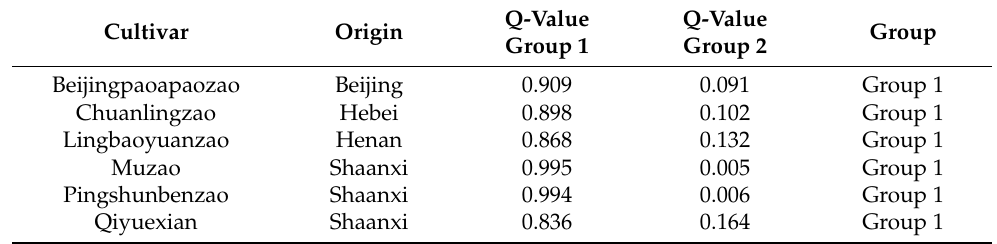
Table 4. Q-values based on Bayesian stratification of 79 Chinese jujube cultivars from Ningxia, China.